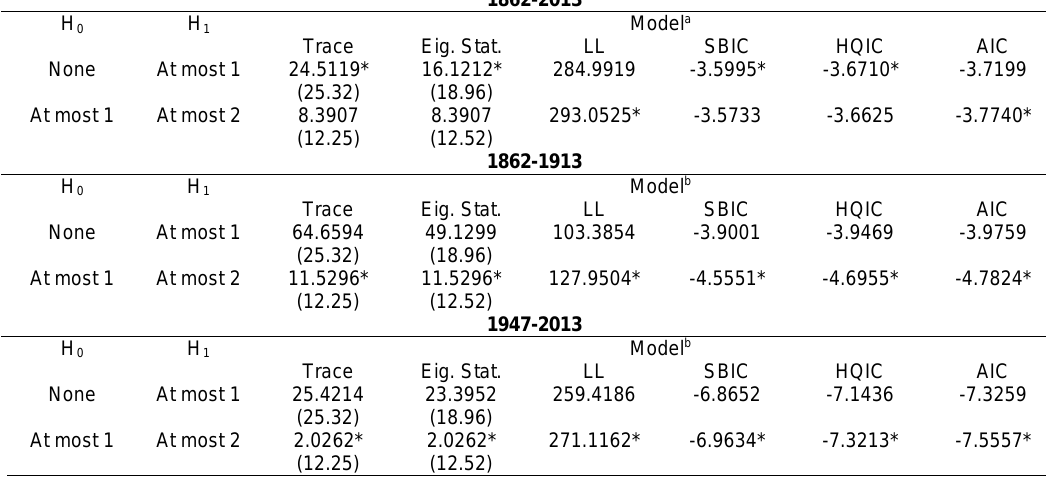
Table 7 . Results for Johansen and Juselius cointegration